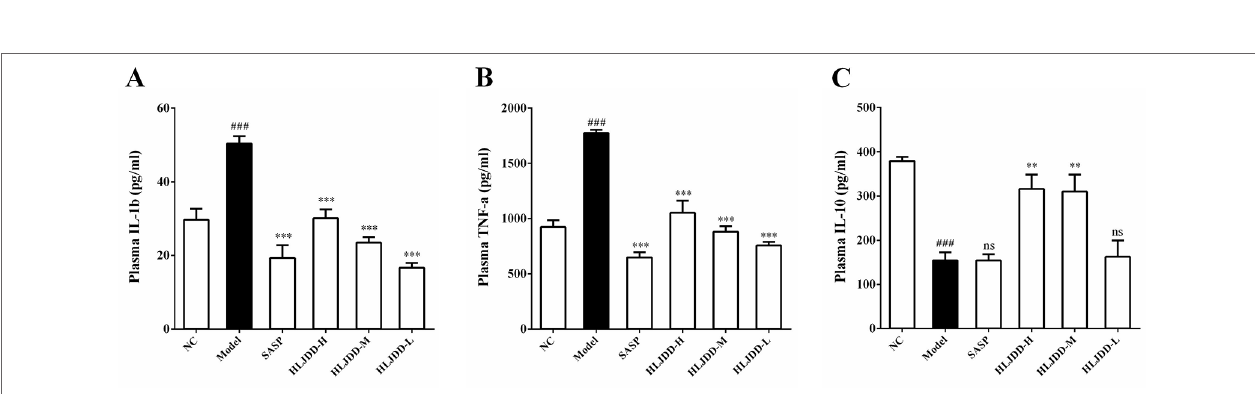
FIgURE 5 | Effects of HLJDD on plasma cytokines in UC mice. Treatment with HLJDD down-regulated plasma IL-1β (A) , TNF-α (B) , and up-regulated IL-10 (C) levels in UC mice. Data are expressed as the mean ± SD, n = 5 per group. ### p < 0.001 vs. NC group; ** p < 0.01, *** p < 0.001 vs. model group. ns: no